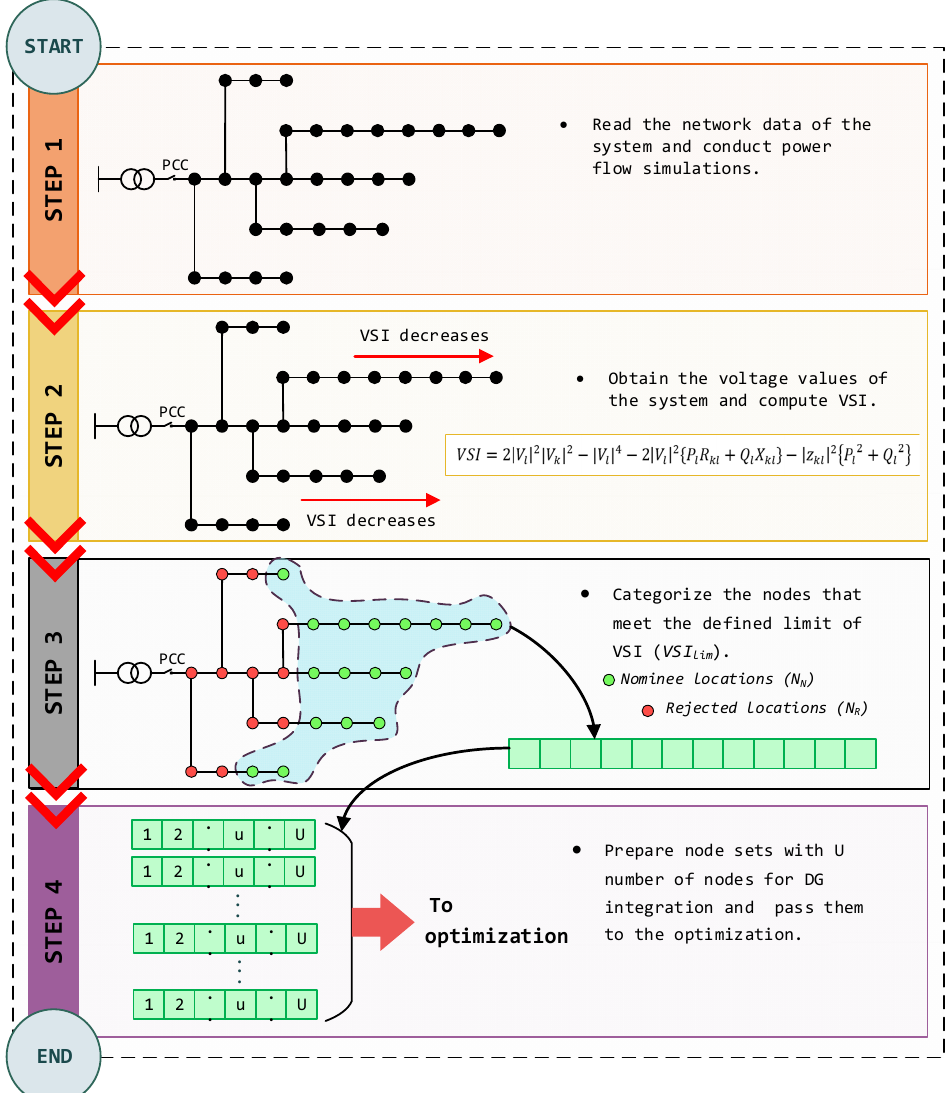
Figure 4. Identifying nominee nodes using a voltage stability index (VSI)-based method-Algorithm 1.